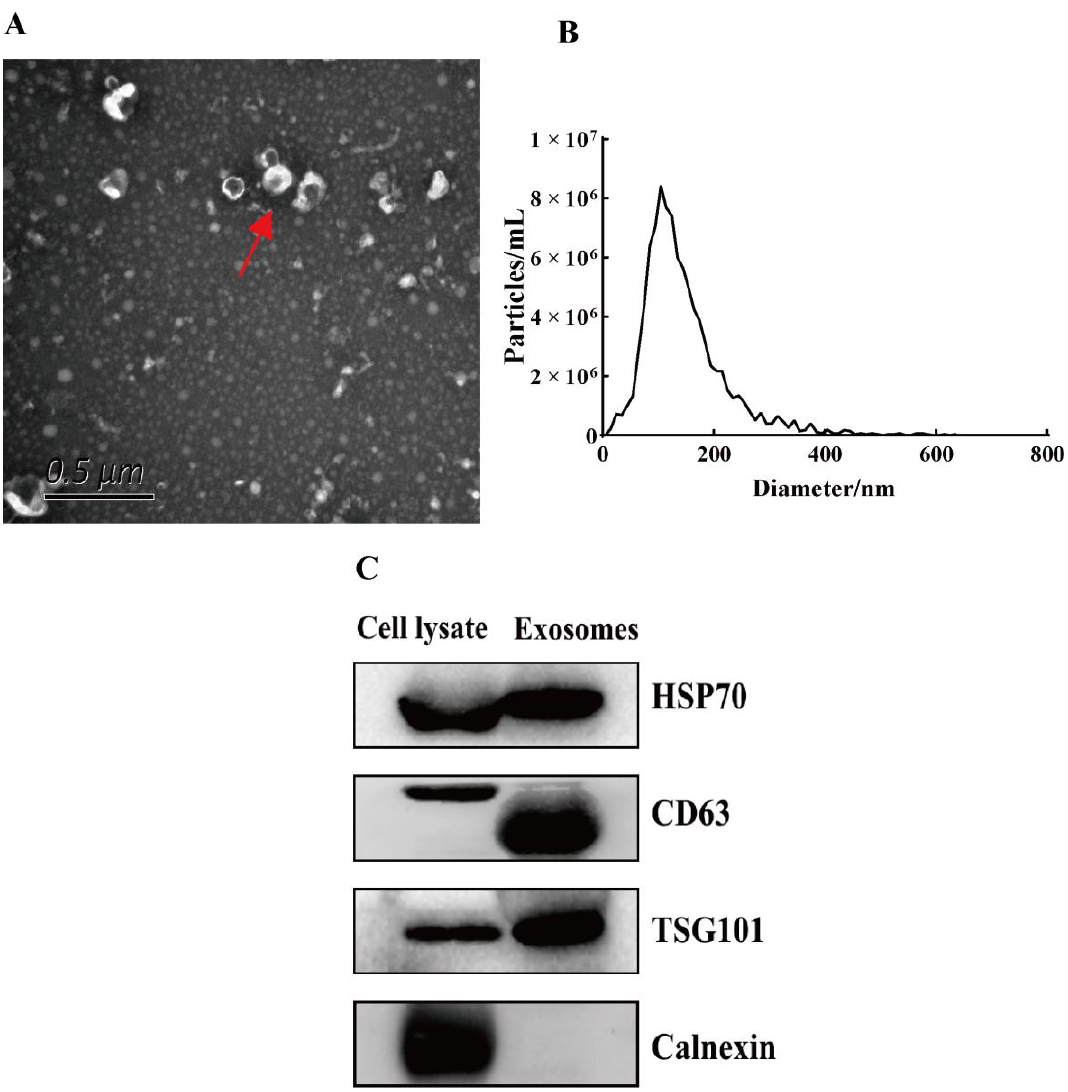
Figure 1. Identification of exosomes. ( A ) Exosomes (red arrow) were observed by transmission electron microscopy. Scale bar: 0.5 µ m. ( B ) The particle size of exosomes was analyzed with NTA. ( C ) Exosome positive markers (CD63, TSG101, and HSP70) and negative marker (Calnexin) were verified by Western blot.